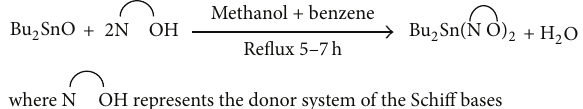
Scheme 1: Representative equation illustrating the formation of dibutyltin(IV) complexes.